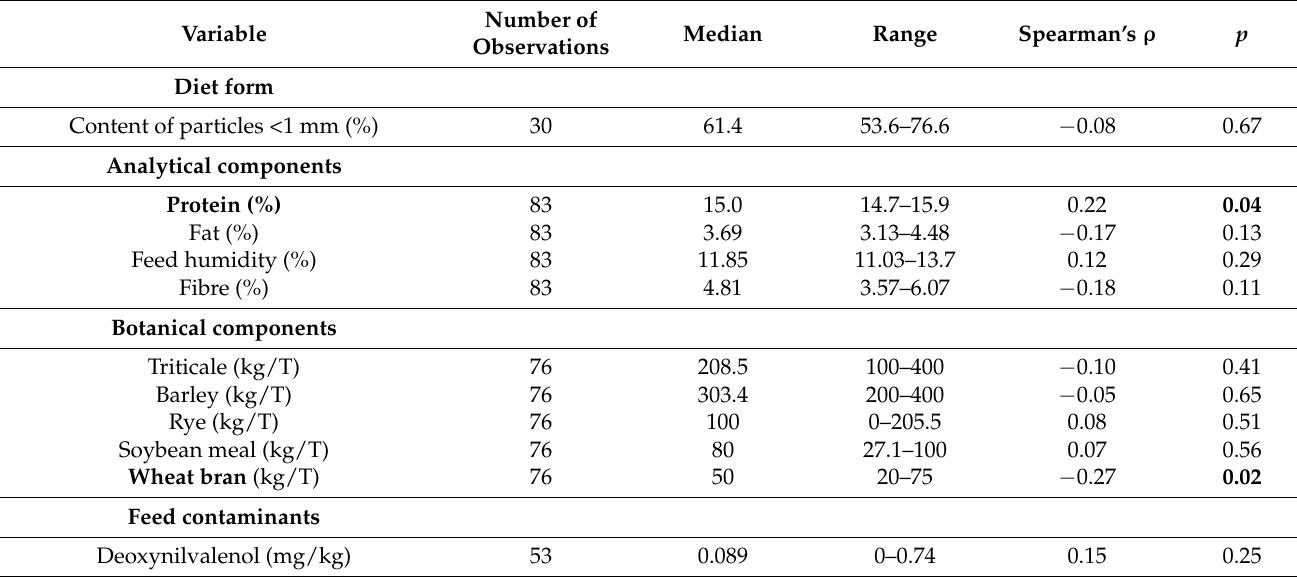
Table 2. Descriptive statistics of the continuous predictor variables and their association with the gastric ulcers prevalence in pig herds.